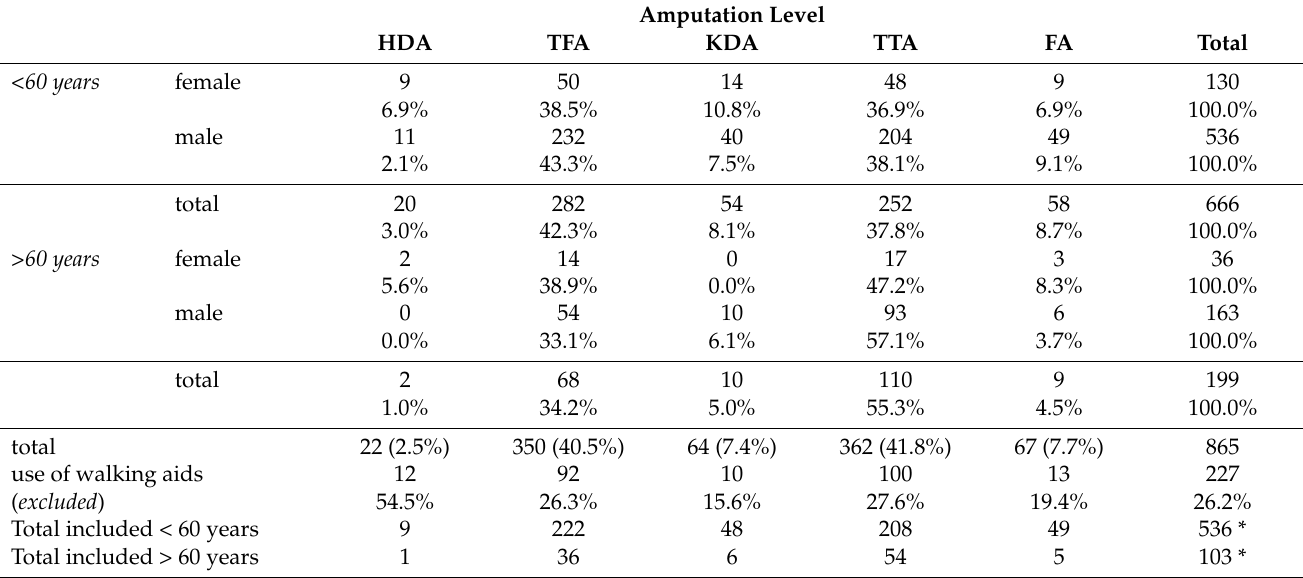
Table 1. Prevalence of amputation levels split by age and